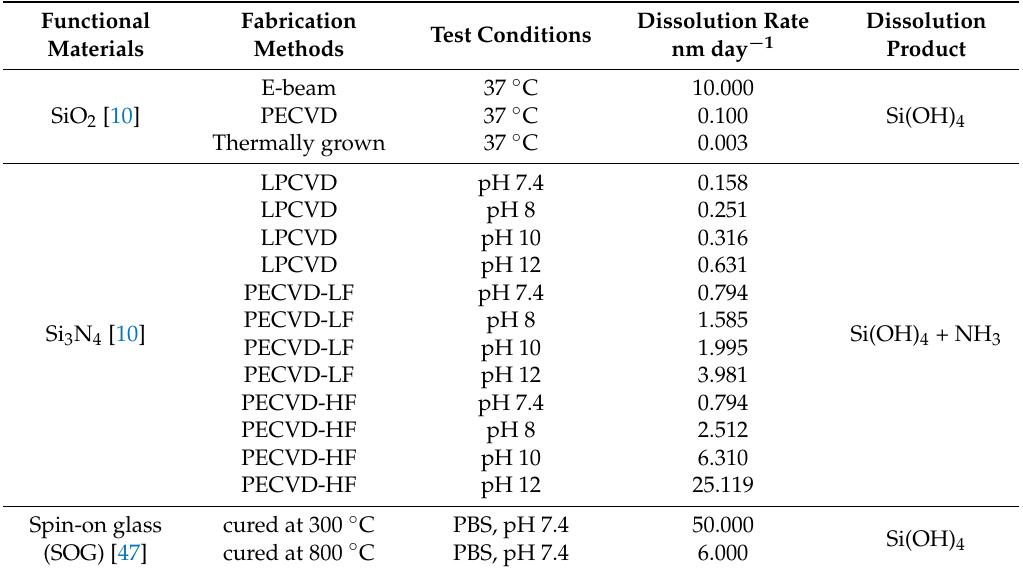
Table 5. Dissolution behaviors of dielectric materials in buffer solution at 37 ◦ C [10,47].